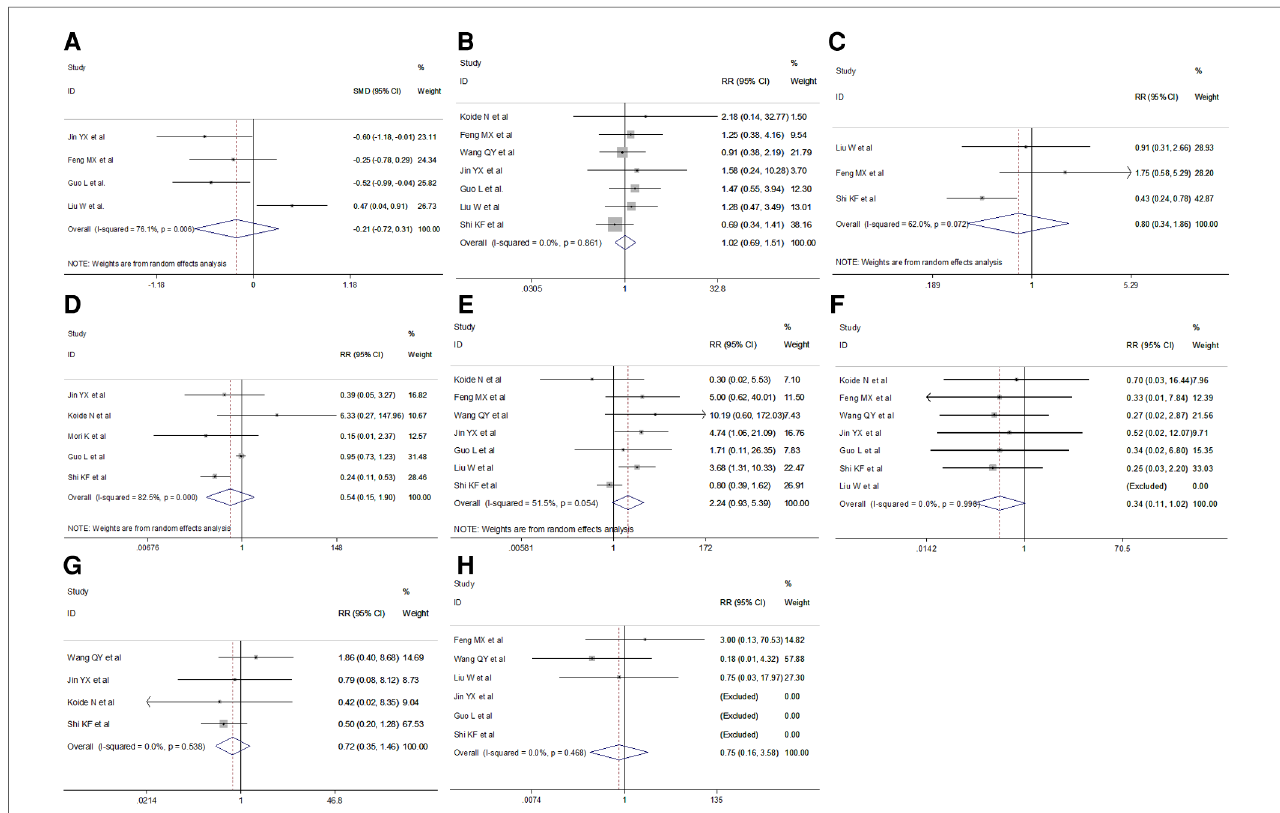
FIGURE 6 Meta-analysis of postoperative outcomes: ( A ) Postoperative hospital stay; ( B ) Anastomotic leakage; ( C ) Respiratory complications; ( D ) Postoperative pneumonia; ( E ) Laryngeal recurrent nerve injury; ( F ) Chylothorax; ( G ) Arrhythmia; ( H )